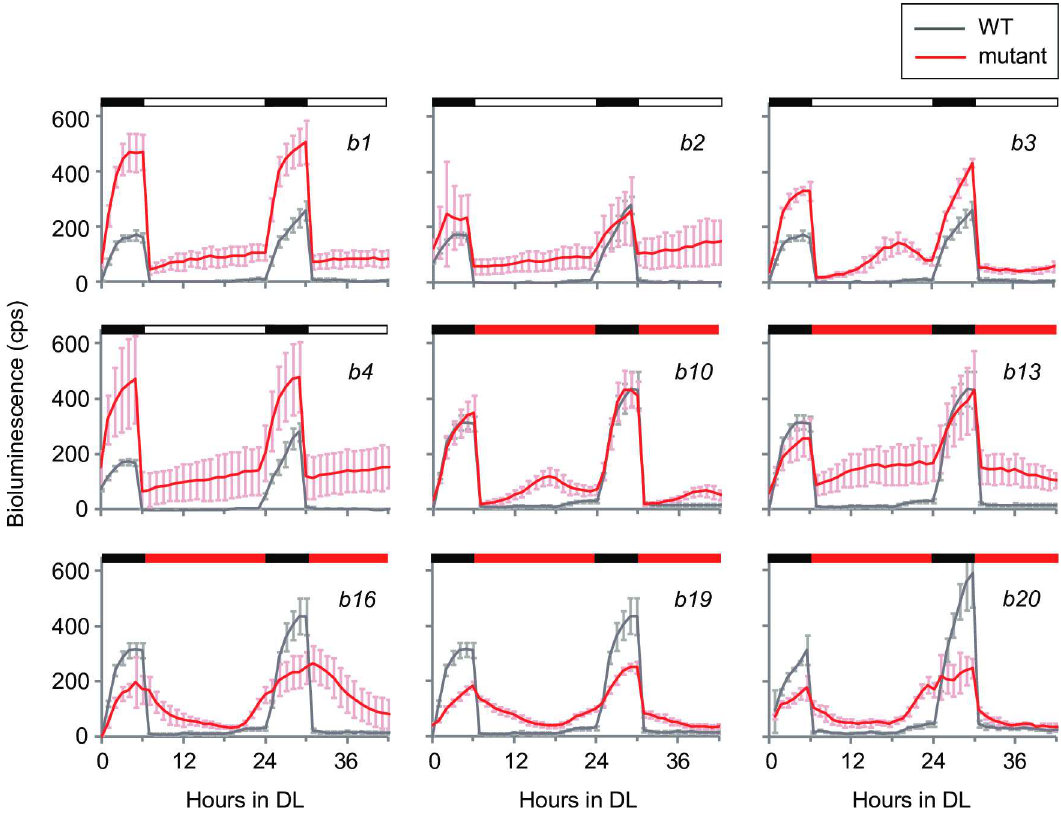
Fig 1. Diurnal rhythms of bioluminescenceof ROC15-LUC in isolated mutants. Asynchronous TAP liquidcultures of mutants in white 96-wellplates were subjectedto two cycles of dark/light. White, red, and black bars represent white light, red light, and dark, respectively.Traces representmeans ± standarddeviation(SD) of bioluminescence levels from 4–6 independent cultures. A trace of the WT strain in the same assay is shown on each graph for